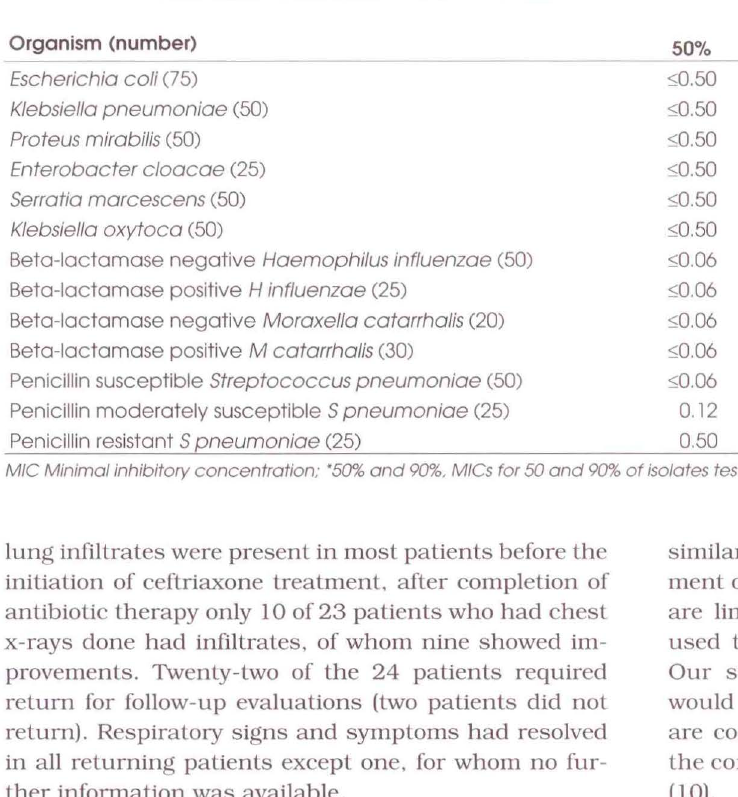
In vitro activity of ceftriaxone against bacterial pathogens commonly associated with lower respiratory tract